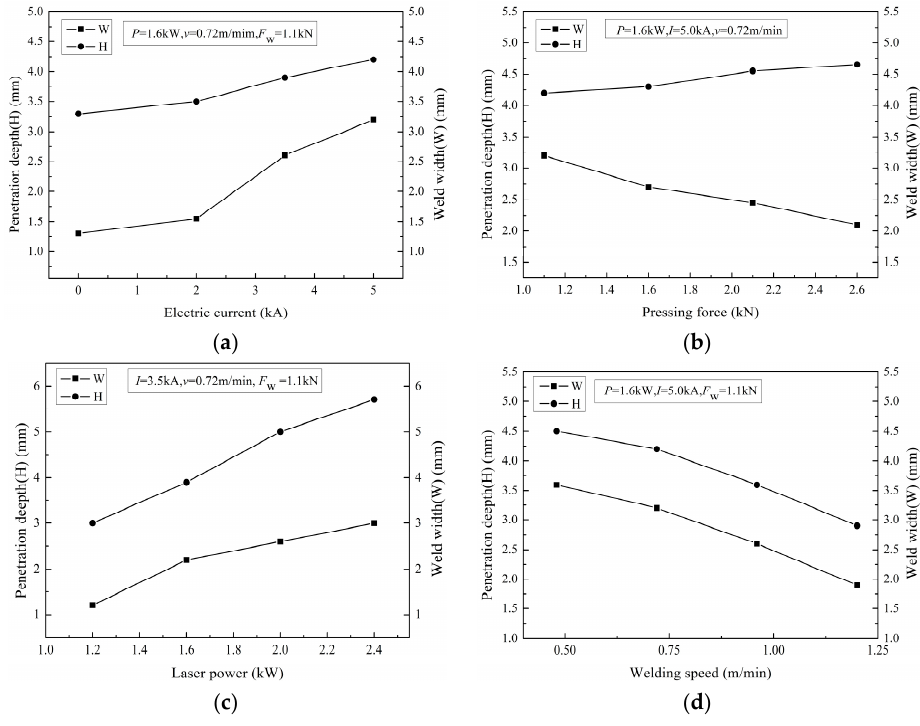
Figure 5. Effects of the different process parameters on the weld morphology ( W , H ): ( a ) electric current; ( b ) pressing force; ( c ) laser power; ( d ) welding speed.